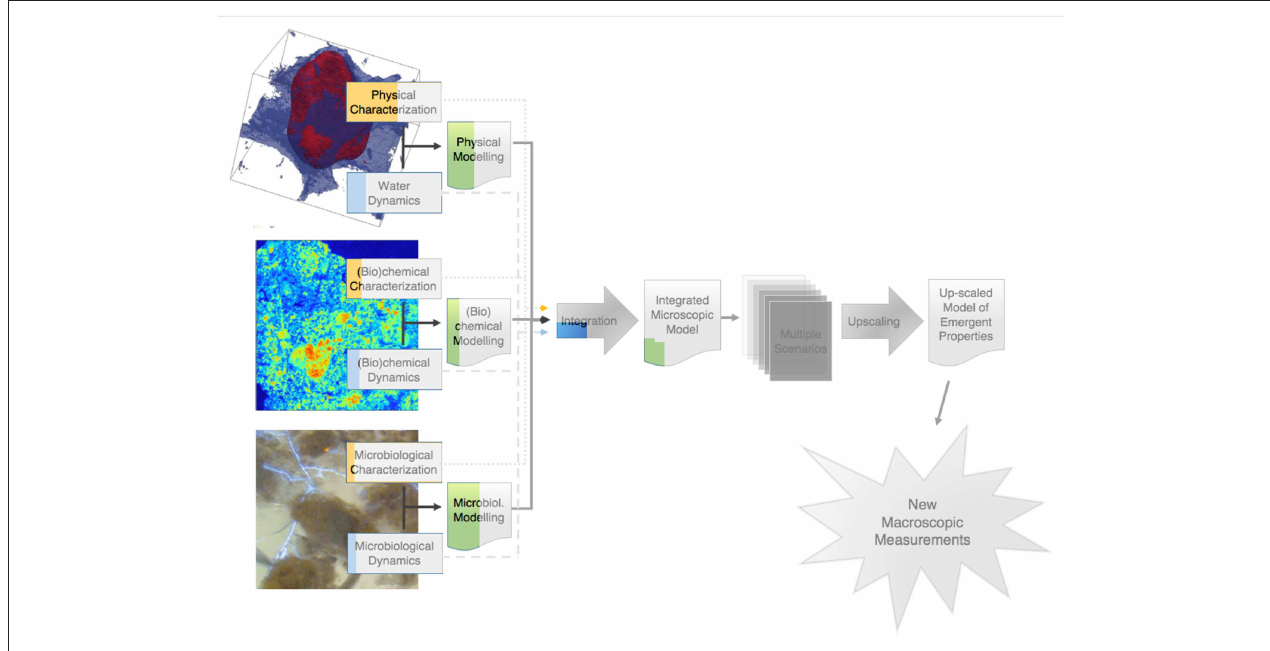
FIGURE 1 | Visual assessment of the level of progress along various paths in the research on the emergent properties of microbial activity in heterogeneous soil microenvironments. The colored parts correspond to Baveye et al.’s estimate of the progress achieved to date along each path. The shaded portions of the diagram still largely remain to be